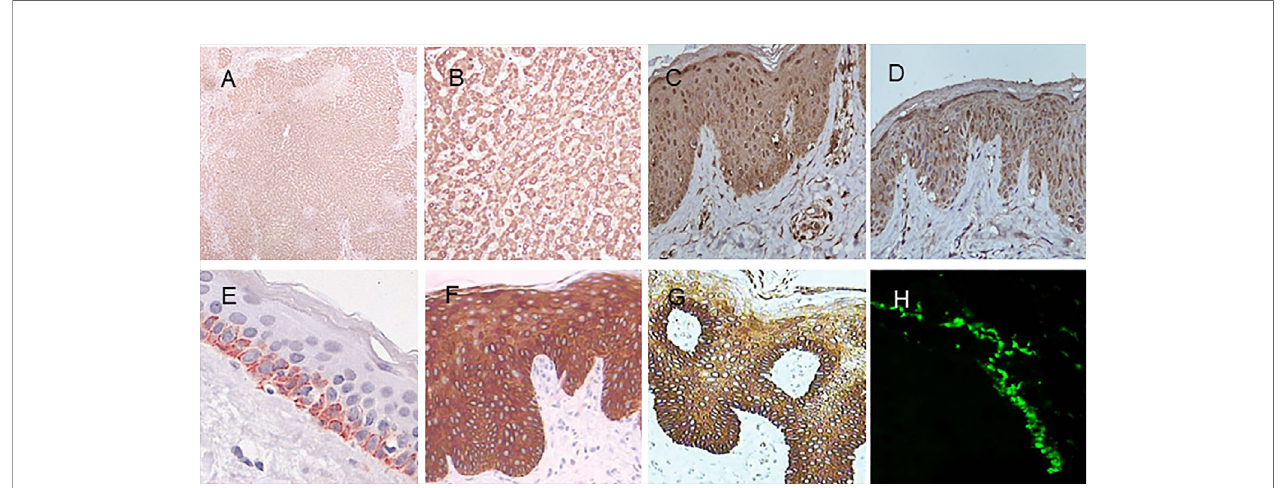
FIGURE 5 | Immunohistochemistry of MBL, SP-A, and SP-D in normal human tissues. (A) MBL in the liver (DAB staining with MBL2 polyclonal antibody, 40×). (B) MBL in the liver (MBL2 polyclonal antibody, 200×). (C) MBL in the skin (MBL2 polyclonal antibody, 400×). (D) SP-A in the skin (SFTPA1 polyclonal antibody, 400×). (E) SP-D in the skin (Hyb 245-1,400×). (F) SP-D in psoriasis lesions (monoclonal antibody Hyb 245-1, 400×). (G) SP-D in atopic dermatitis (monoclonal antibody Hyb 245-1, 400×). (H) Deposition of MBL in the basal membrane zone with granular pattern by immuno fl uorescence. Panel (E) was modi fi ed and reprinted from Madsen, et al. in 2015 (43). Panel (F, G) are modi fi ed and reprinted from Hohwy, et al. in 2006 (44). Panel (H) was modi fi ed and reprinted from Wallim LR et al. in 2014